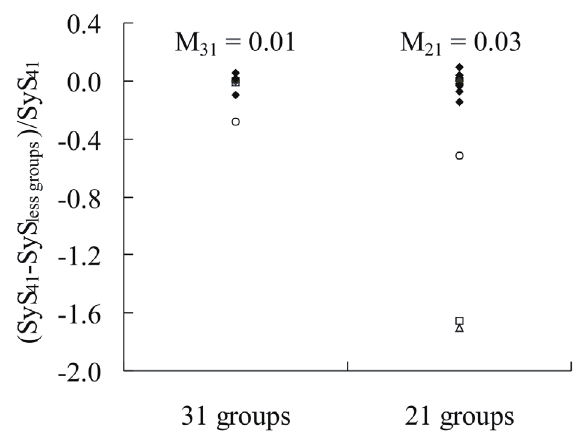
Fig . 6. – Variation of the system statistics (SyS) for the East Brazil Large Marine Ecosystem obtained with Ecopath with Ecosim mod- els using 31 and 21 groups (SyS ) in relation to the original 41 less groups groups model (SyS ). Open circles correspond to the connectance 41 index, open squares to the throughput cycled (excluding detritus), and open triangles to the predatory cycling index. M and M indi- 31 21 cate the mean absolute variation of the system statistics using 31 and 21 groups in relation to the baseline (41